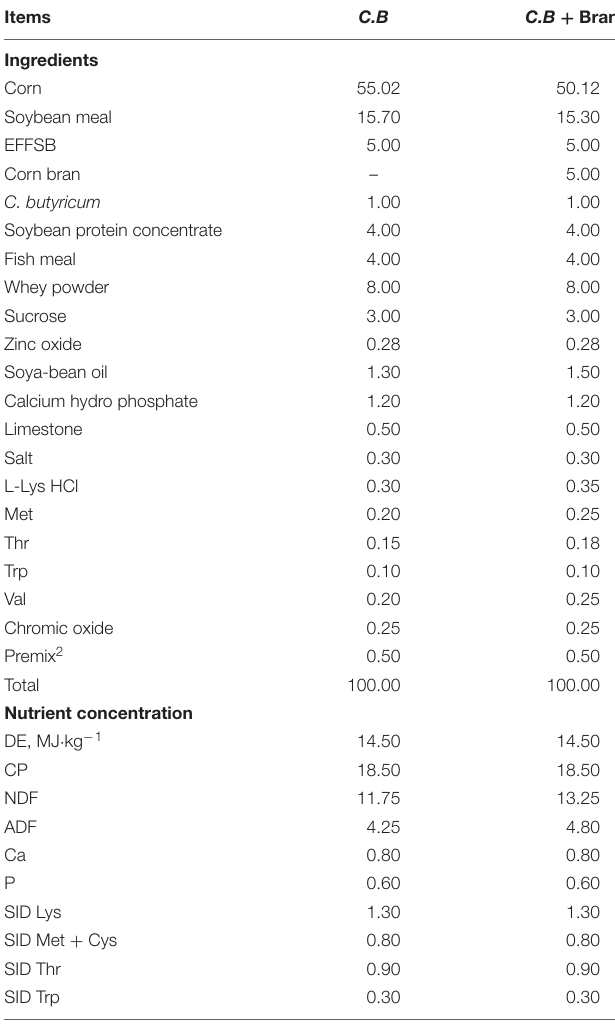
TABLE 1 | Ingredient composition and nutrient content of experimental diets (%, Dry matter basis) 1